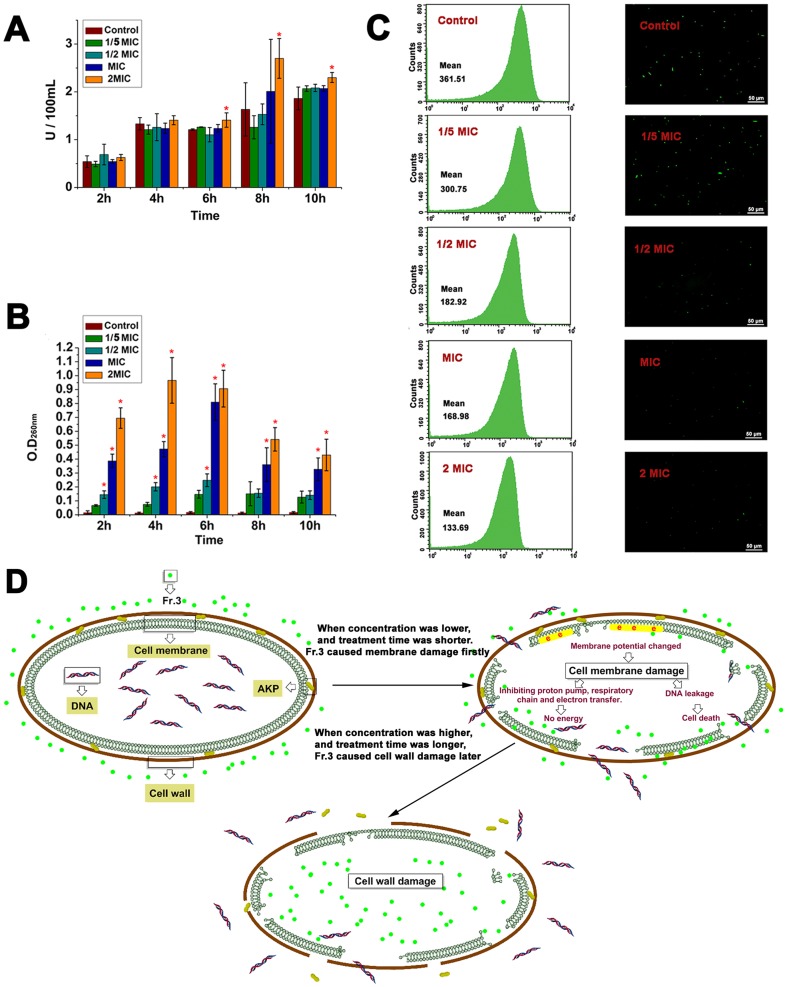
Effects of Fractionation three on the cell wall and cell membrane permeability.Effect of Fractionation three on the alkaline phosphatase (AKP) activity of C. michiganense subsp. sepedonicum (A). Effect of Fractionation three on the leakage of nucleotides from C. michiganense subsp. sepedonicum (B). Cell membrane depolarization in C. michiganense subsp. sepedonicum cells treated with Fractionation three (C). Proposed mechanism of cell wall and cell membrane disruption by Fractionation three treatment (D). Different letters indicated a significant difference (P<0.05; ANOVA and Duncan’s multiple range test). Bars represent the mean ± standard deviation. Each experiment was replicated three times. Analysis of cell membrane potential by flow cytometry (C left panel) and fluorescence microscopy (C right panel, 20×). MIC, Minimum inhibitory concentration; Fr.3, Fractionation three.